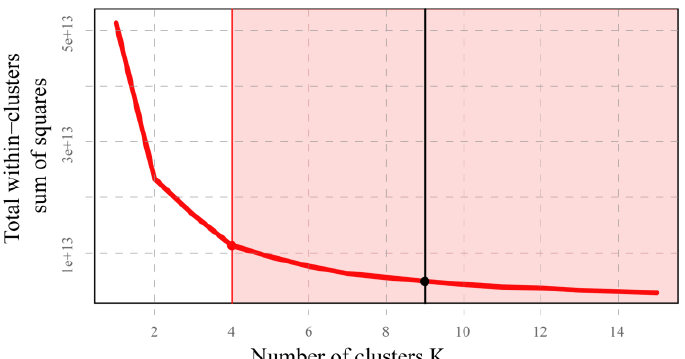
Figure 17. Elbow method illustrating the relationship between the number of clusters k and the total within-clusters variation. The vertical line indicates minimal number of clusters. The black vertical line indicates the chosen number of clusters.